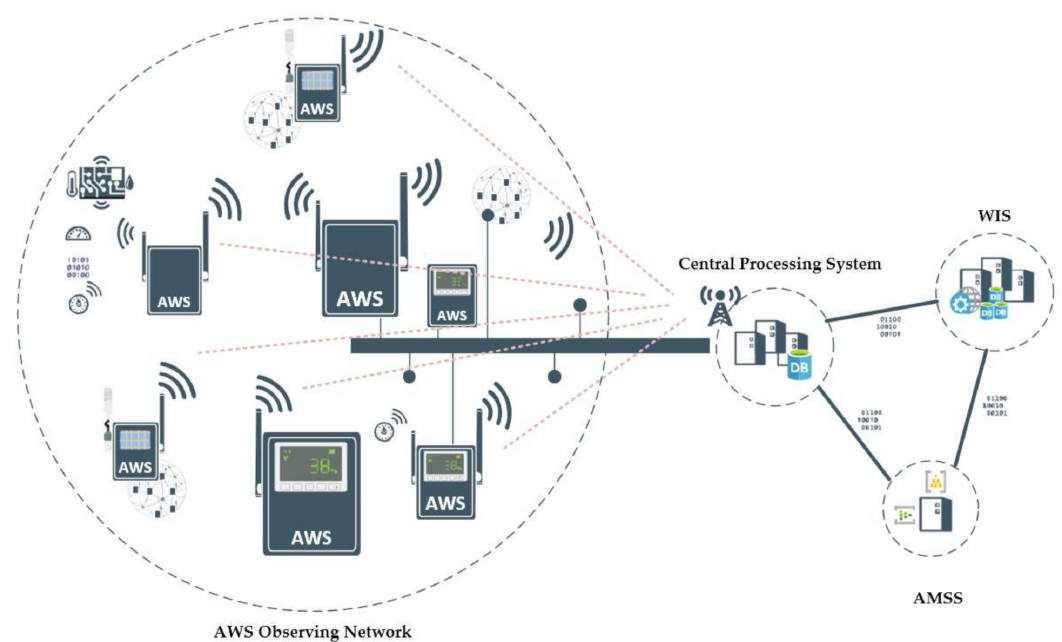
Figure 1. An integrated observing system based on World Meteorological Organization (WMO) system